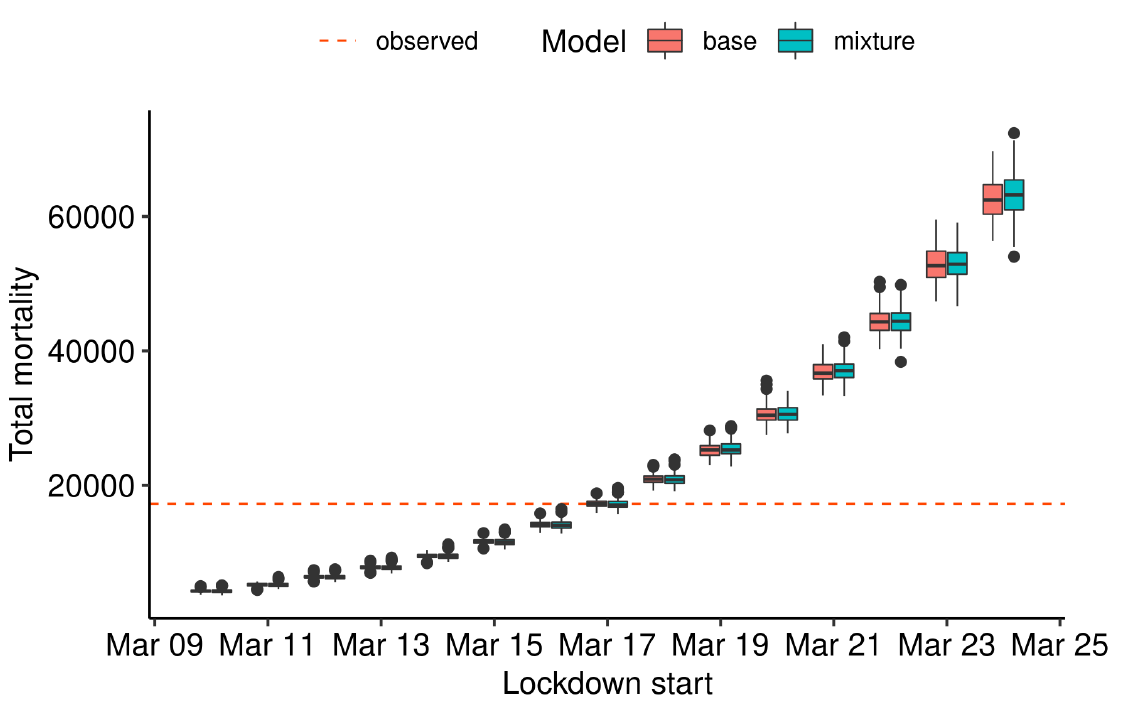
Figure 11 – Effect of different lockdown dates in counterfactual scenarios. Both models were used to predict the total number of deaths on May 11 if the lockdown was put in place up to 7 days before or 7 days after the actual lockdown date on March